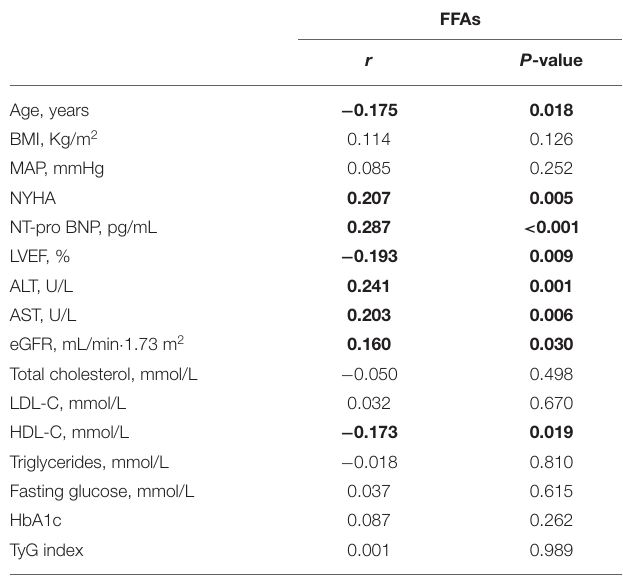
TABLE 2 | Correlation analyses of free fatty acids with clinical and laboratory